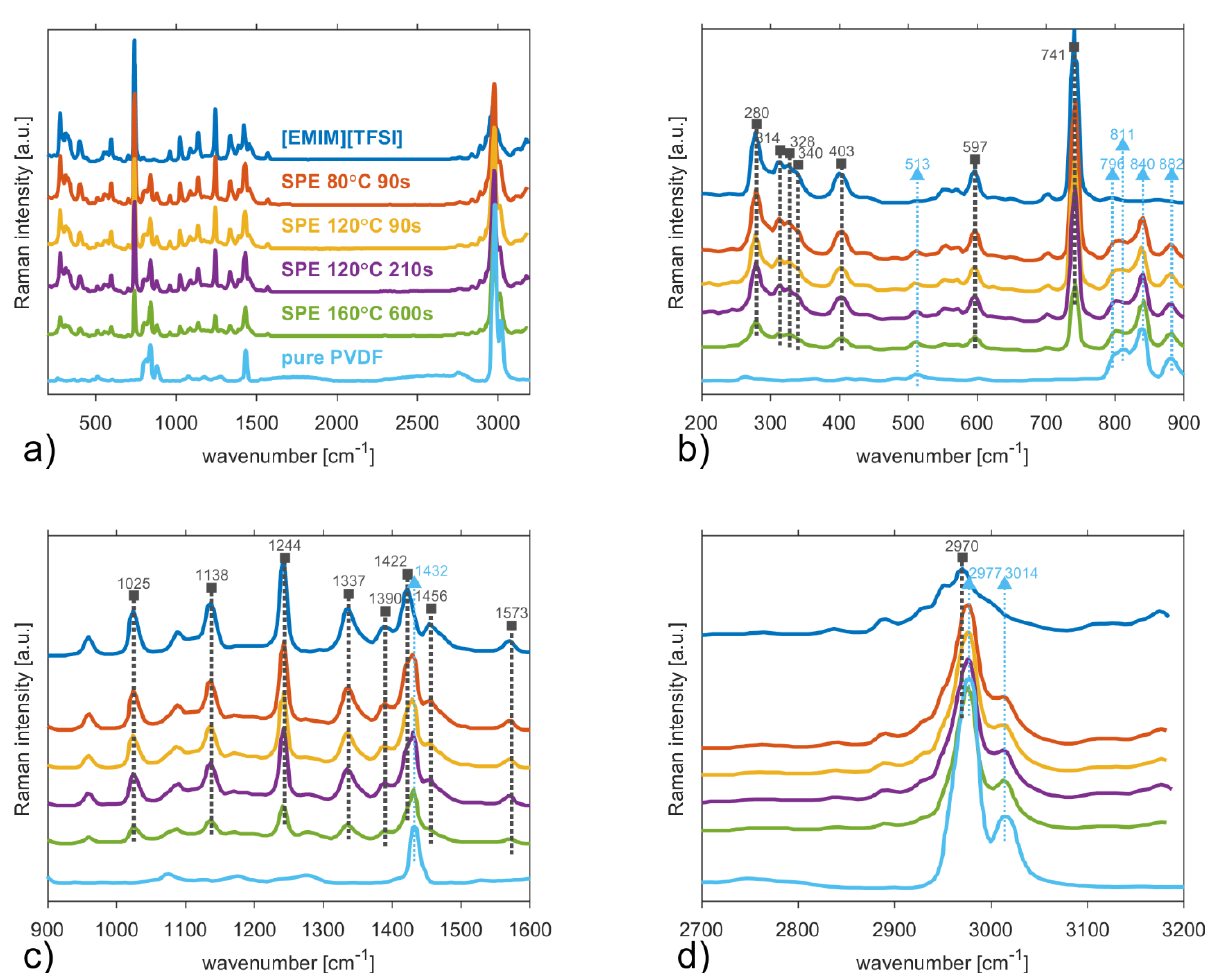
Figure 2. Raman spectra of ionic liquid [EMIM][TFSI], solid polymer electrolytes after four treatment conditions and PVDF in ( a ) full spectral range 200–3200 cm − 1 , ( b ) spectral range 200–900 cm − 1 , ( c ) spectral range 900–1600 cm − 1 , and ( d ) spectral range 2700–3200 cm − 1 . Grey lines and squares represent significant peaks connected to ionic liquid. Cyan lines and triangles are connected to PVDF peaks ( ▲◄▼ ).